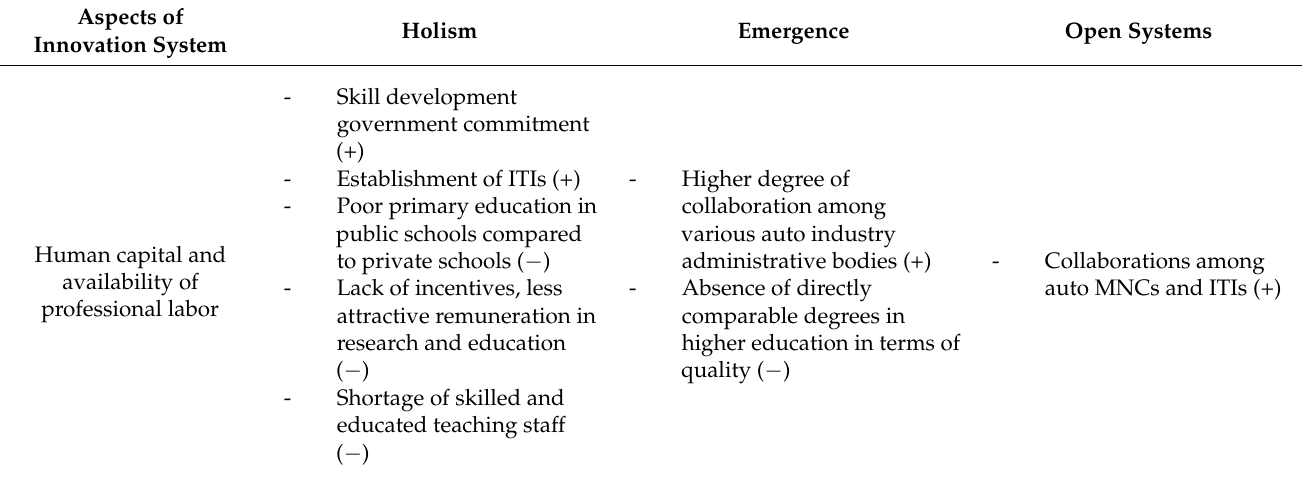
Table 5. The systems perspective of India’s automotive